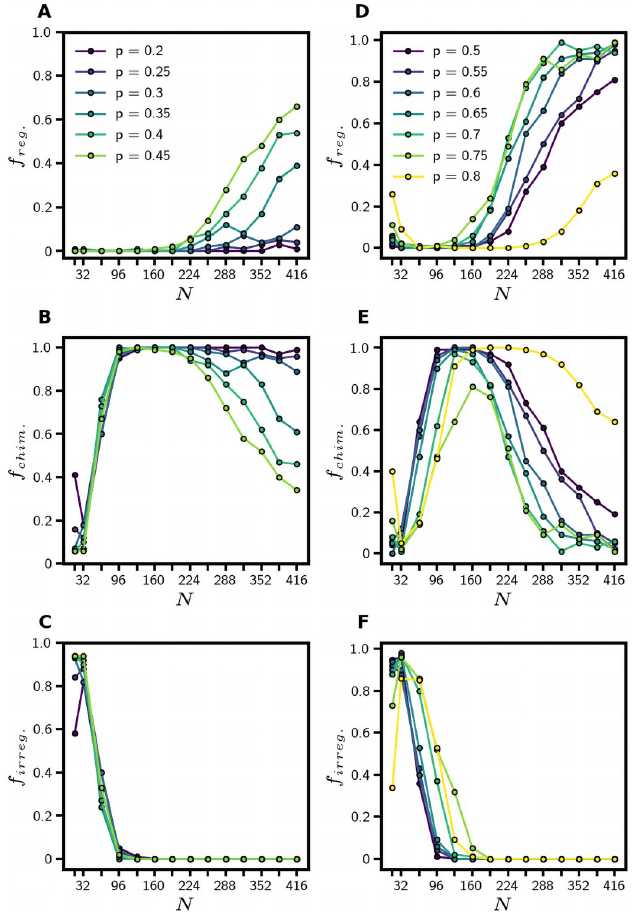
Fig 4. Effect of network size on state frequencies. Panels A-C show the frequency of temporally-regular, chimera, and temporally-irregular states with network size N and p = 0.2, 0.25, ... , 0.45. Each point represents a fraction of 100 networks whose dynamics were generated from random initial conditions; this means that the frequency of each state for a single value of N and p should add to one. Panels D-F show the frequency of the three dynamical classes for the same range of N and p = 0.5, 0.55, ... ,